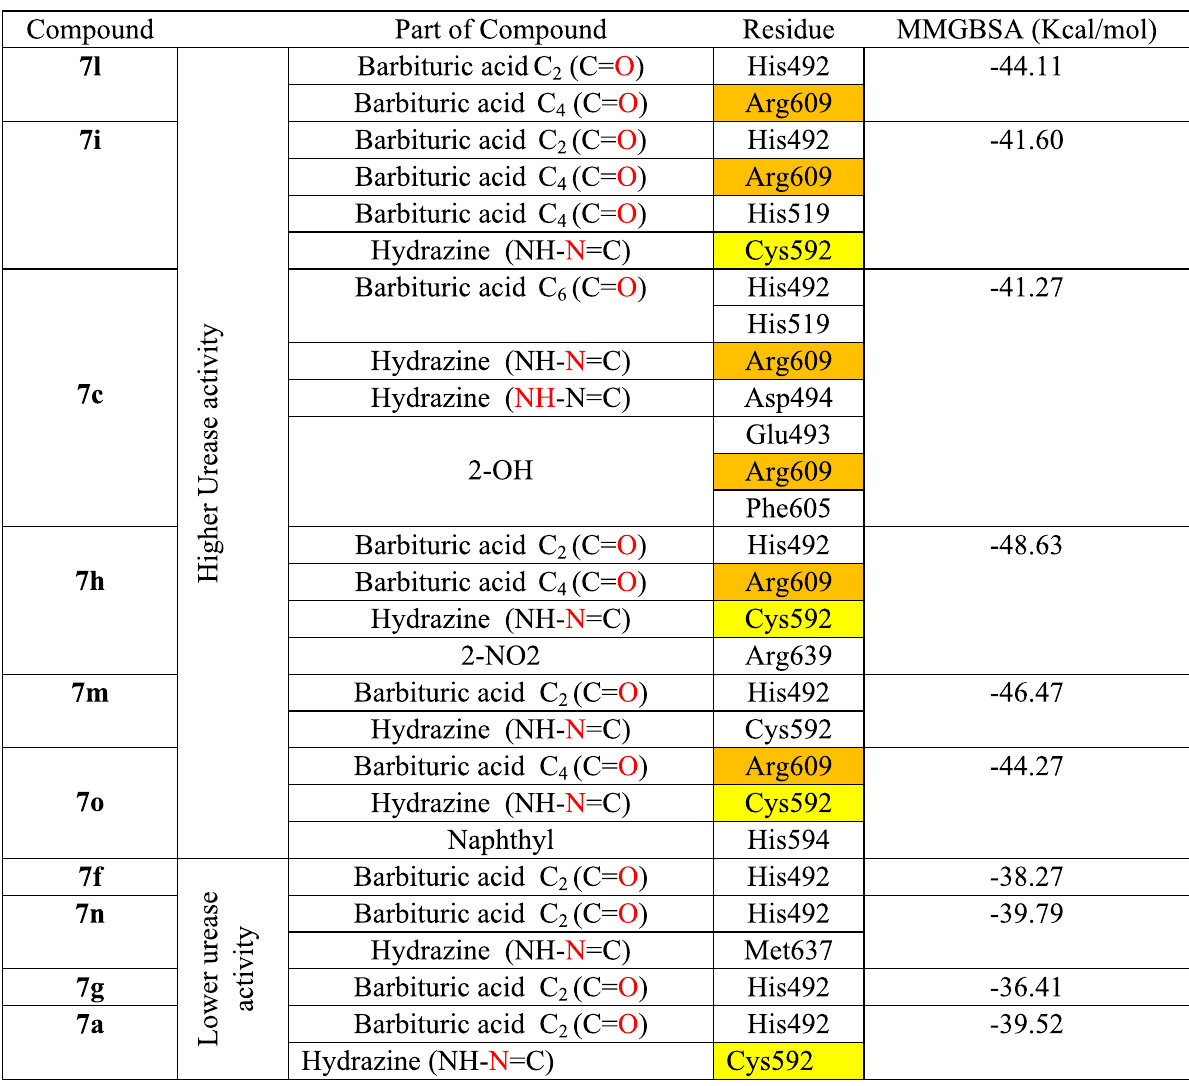
Table 2. The calculated gibbs free binding energy and the residue involvement in IFD complex of some of the synthesized